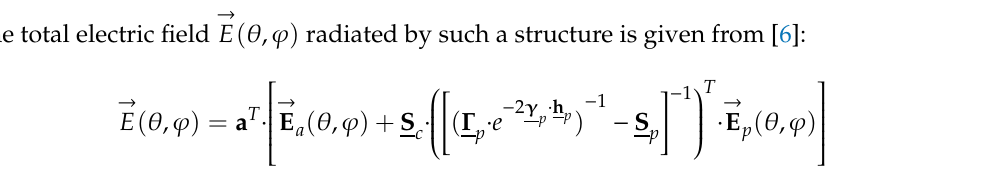
Figure 1. Schematic view of a reactively loaded waveguide antenna array.